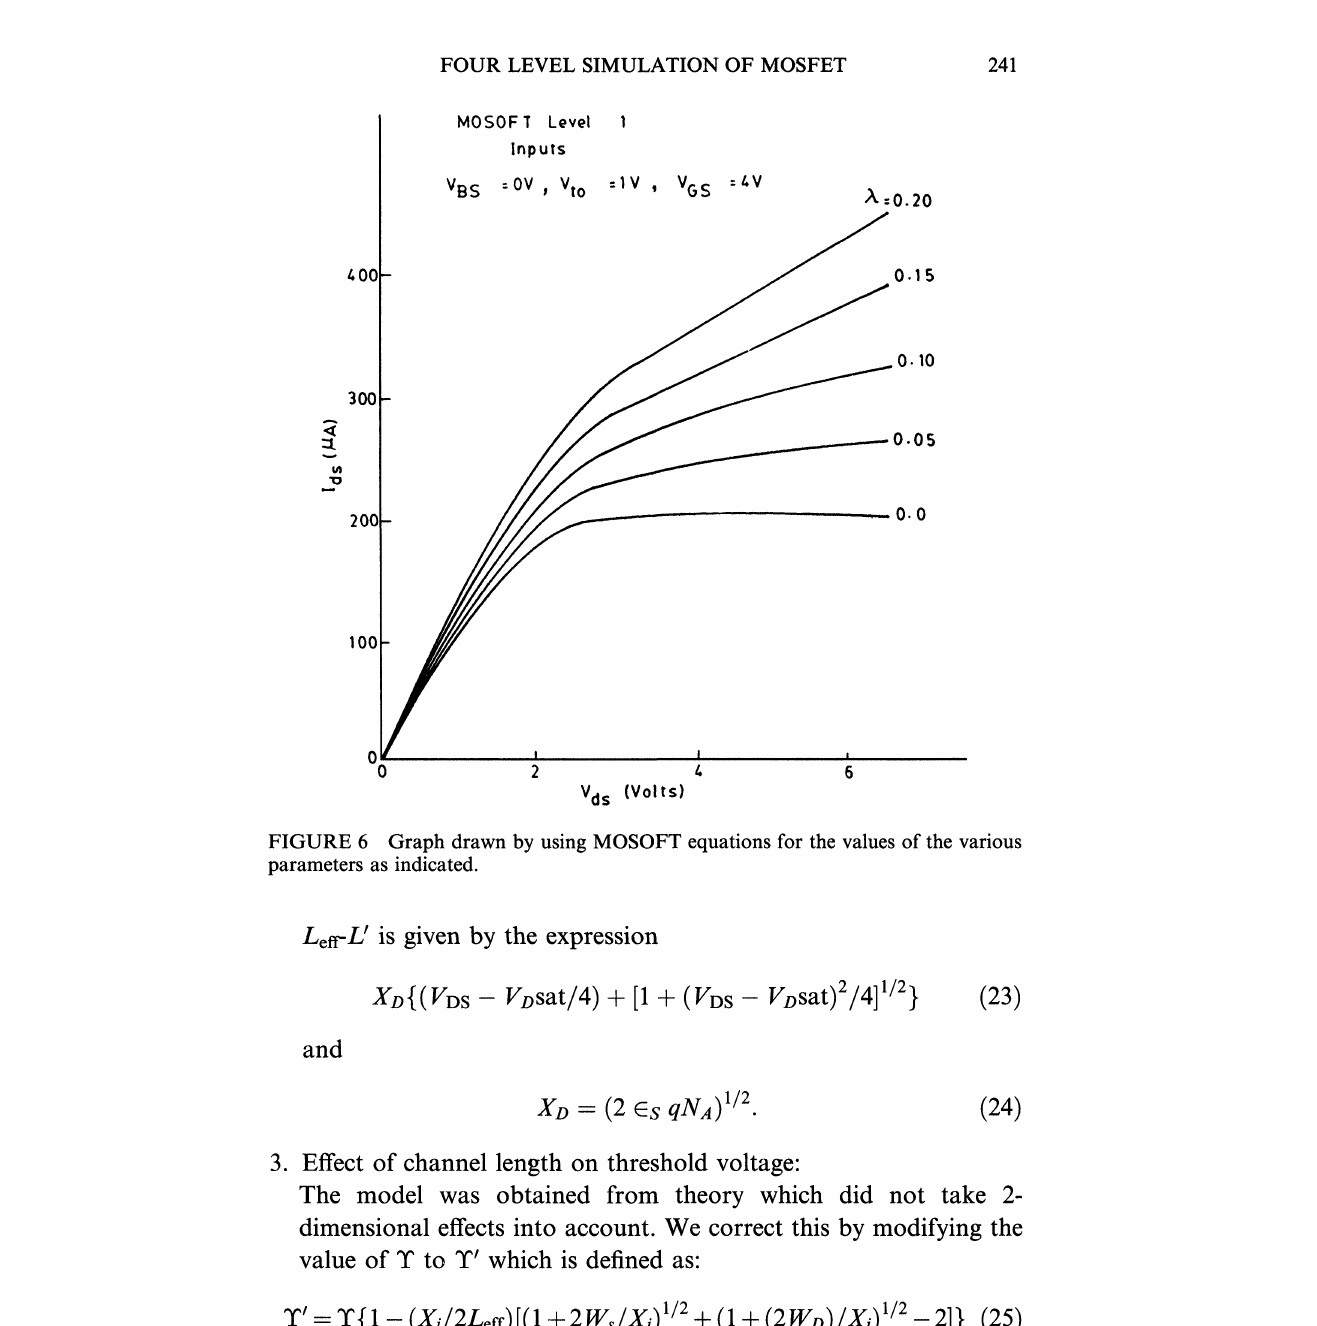
FIGURE 6 Graph drawn by using MOSOFT equations for the values of the various parameters as